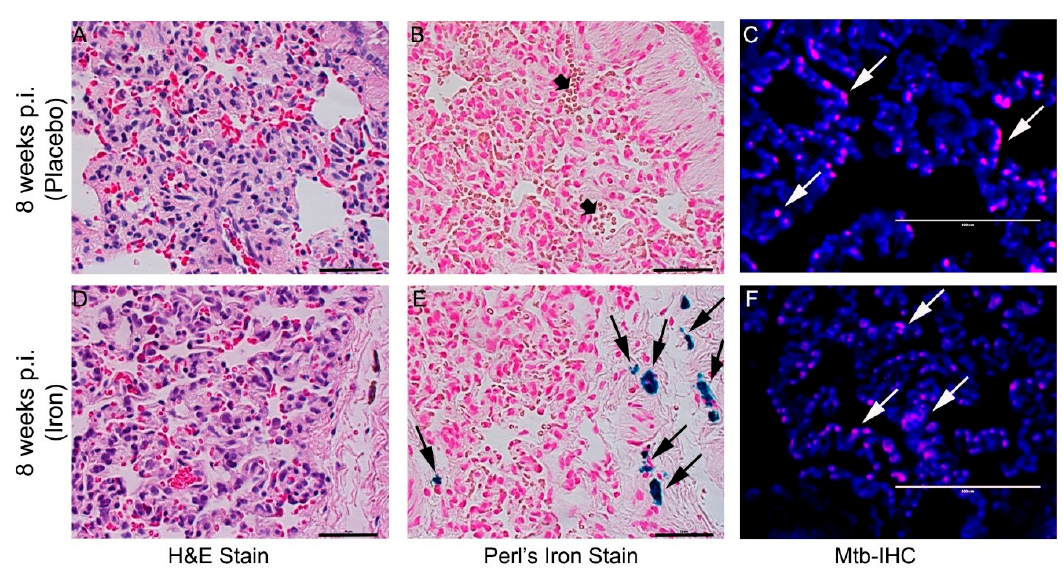
Figure 8. Effect of Fe-supplementation on rabbit lung pathology at 8 weeks post Mtb infection. Histopathology of rabbit lungs infected with Mtb CDC1551 at 8 weeks post infection with ( A – C ) or without ( D – F ) Fe-supplementation showing disease pathology (H&E stain; A , D ), iron deposition (Perls’ iron stain; B , E ) and Mtb (by immunohistochemistry; C , F ). Dark arrows in ( E ) show cellular iron deposition (blue color). White arrows in ( C , F ) show Mtb (purple color). The scale bar for all the images is 50 µm. Sections were photographed at 400× ( A , B , D , E ) or 600× ( C , F ) of original magnification.